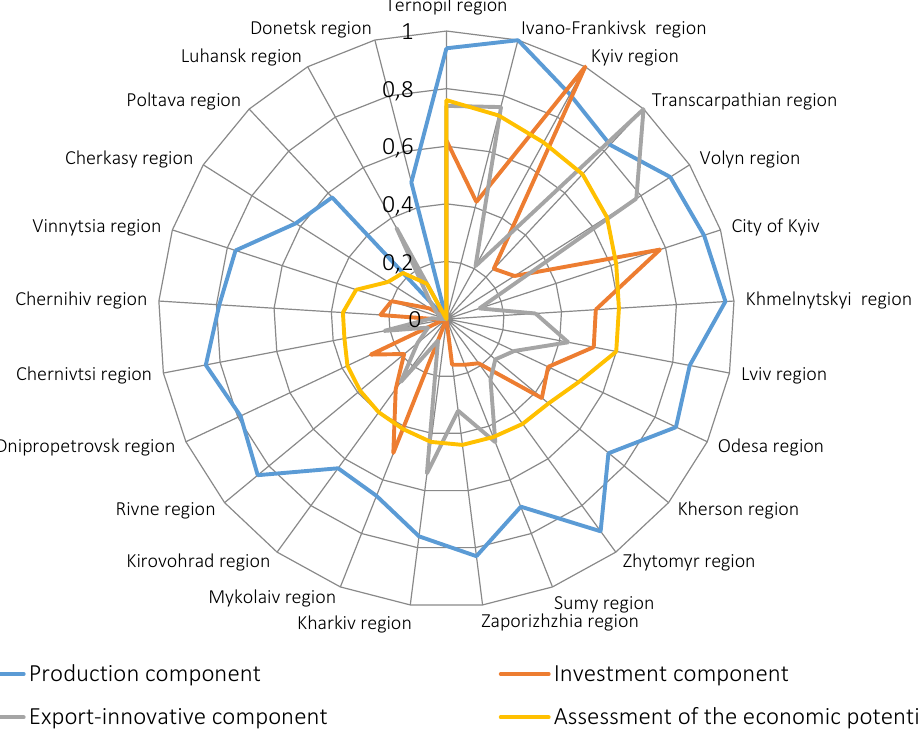
Figure 3. Ranking of Ukrainian regions by economic potential of territories in